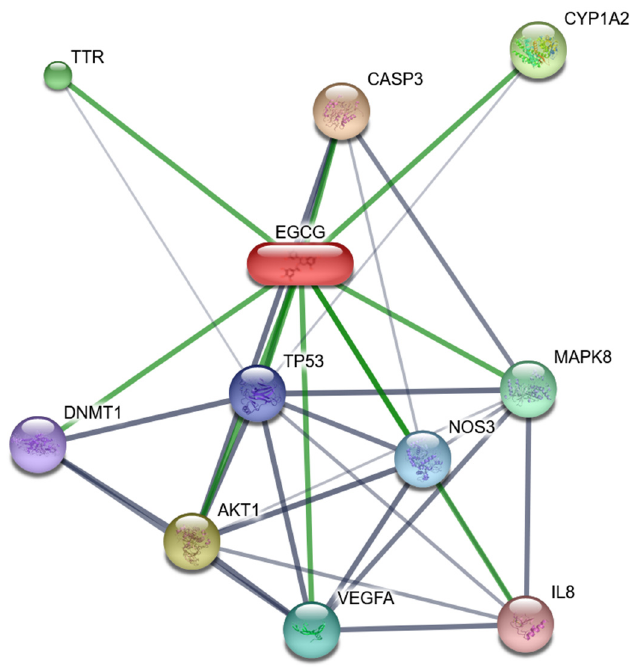
Figure 8. The interactive network of proteins and Epigallocatechin ‐ 3 ‐ gallate (EGCG). The interactive network of proteins and EGCG, the Interactive nodes with the top ten interaction scores were shown. Lines represent protein ‐ protein associations that are meant to be specific and meaningful. Proteins jointly contribute to a shared function and stronger associations are represented by thicker lines. Protein–protein interactions are shown in grey, EGCG ‐ protein interactions in green.